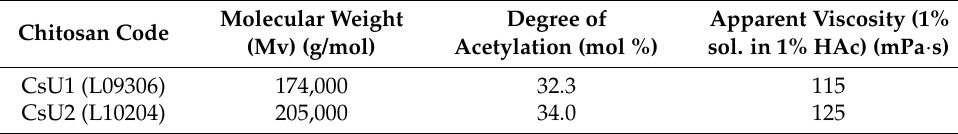
Table 1. General information about the used medical grade CsUs.